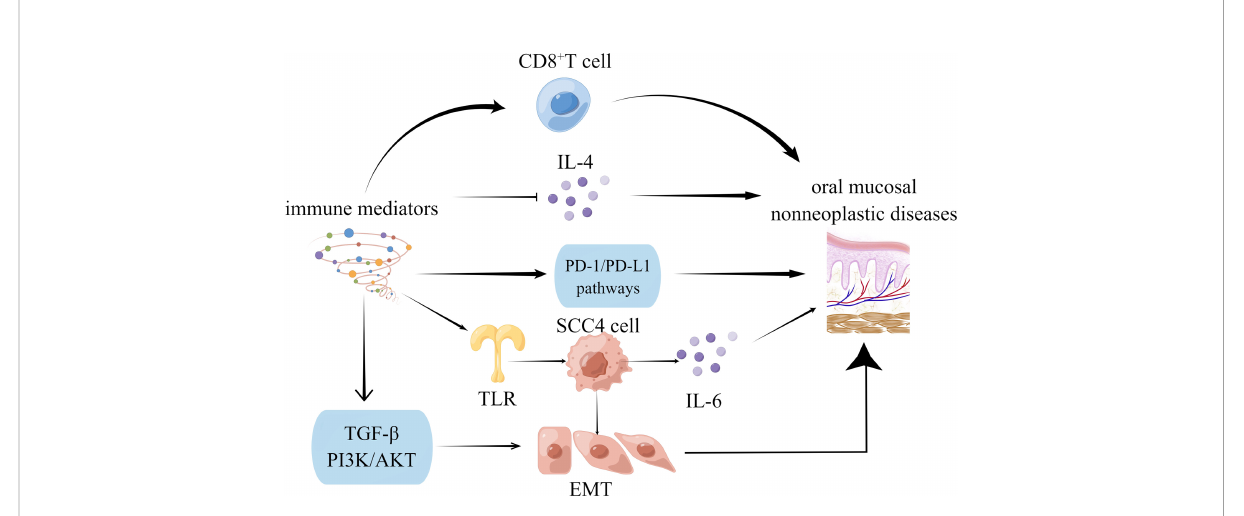
FIGURE 2 Oral mucosal non-neoplastic diseases were mediated by immune microenvironment.